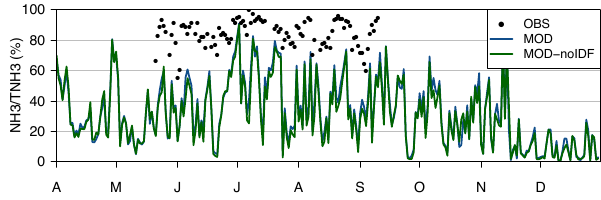
Figure 5. Daily NH 3 / TNH 3 ratios in observations (points) and simulations (solid lines).